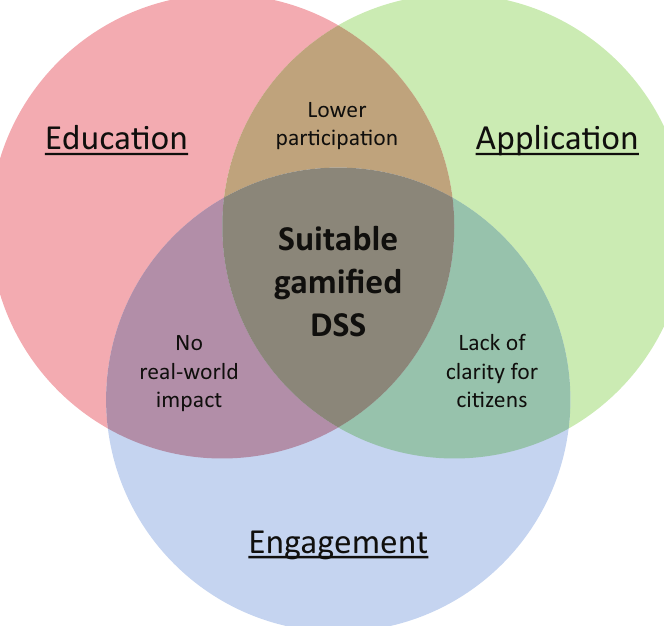
Figure 2. The engagement, education, and application framework for gamified